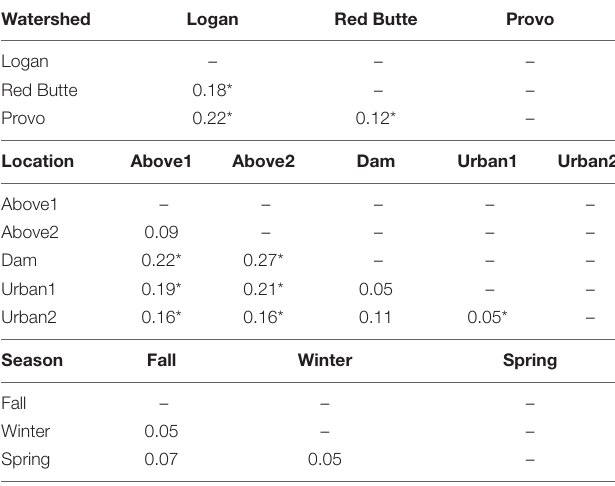
TABLE 5 | Pairwise PERMANOVA results comparing bacterioplankton community composition across three watersheds, at five locations, and three seasons.